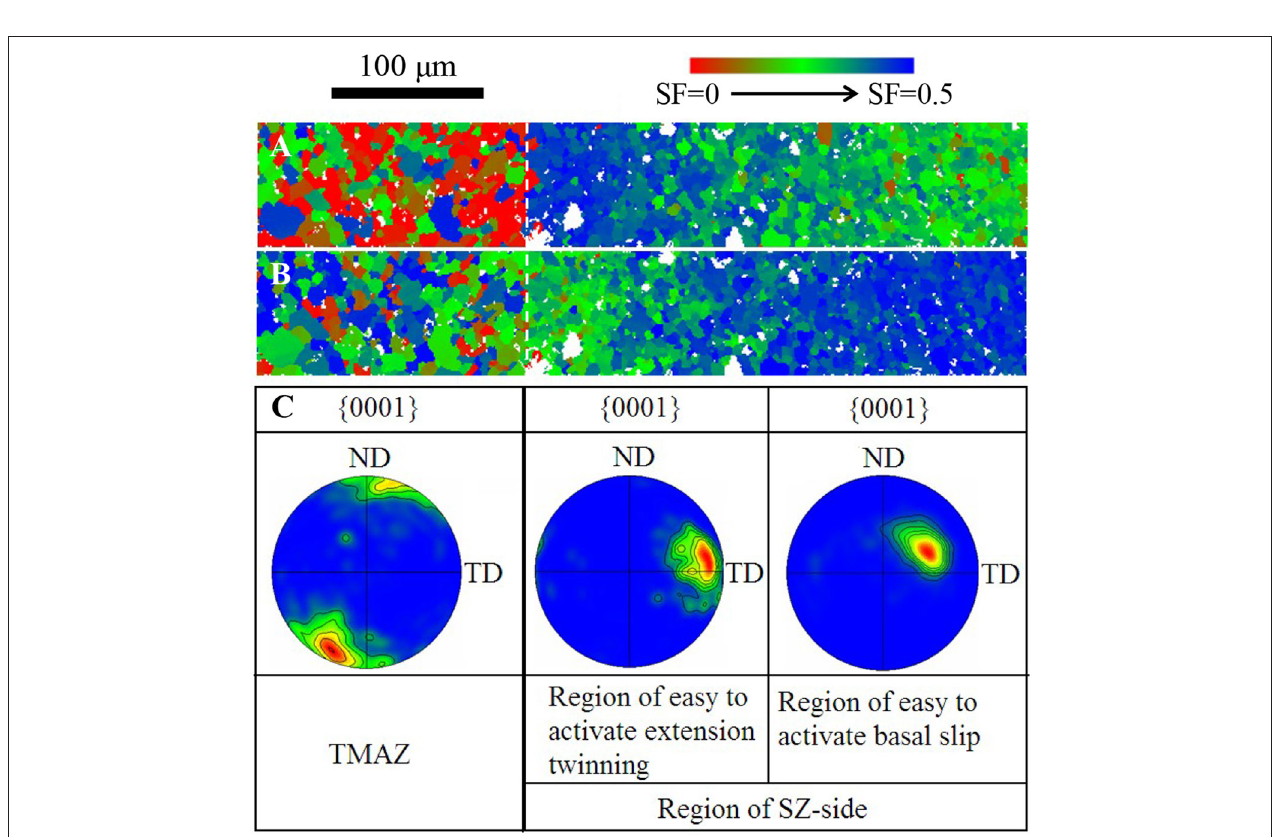
FIGURE 7 | SF maps of deformation mechanisms for tension along TD at the transition region between TMAZ and SZ-side on AS (Xin et al., 2013a): (A) extension twinning, (B) basal slip; (C) {0001} pole figures at the transition zone (Copyright © 2013, ELSEVIER S.A.).